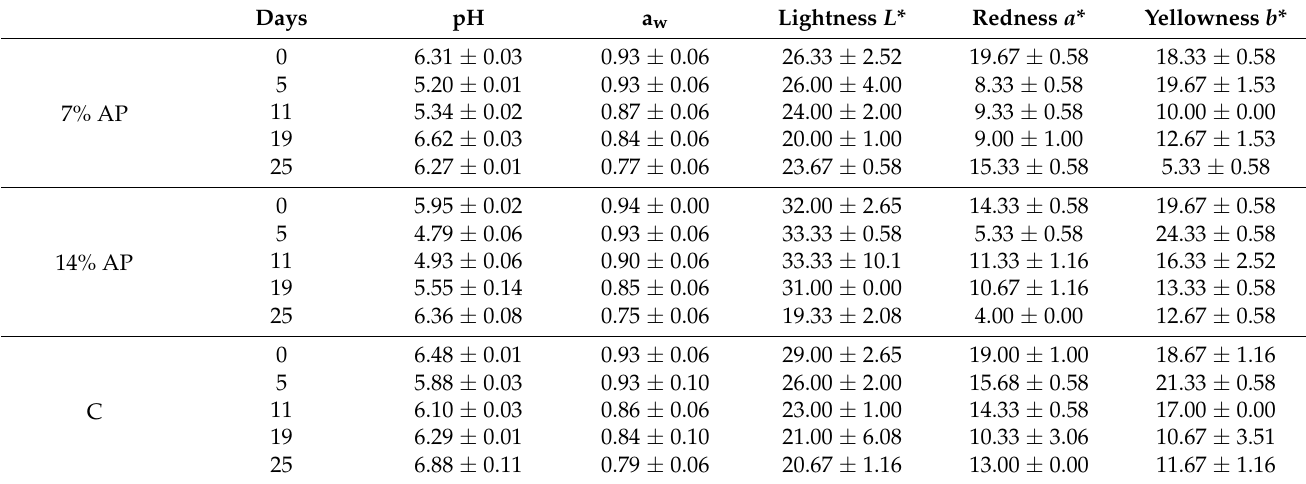
Table 3. Values of pH, a w and colour coordinates ( L *, a * and b *) of fortified salami, sampled at different times (mean values ± SD, n =